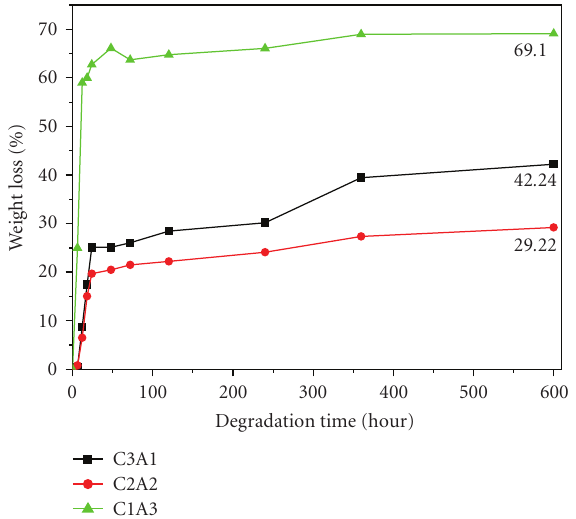
Figure 4: In vitro degradation of CA sponge in PBS lysozyme solution.